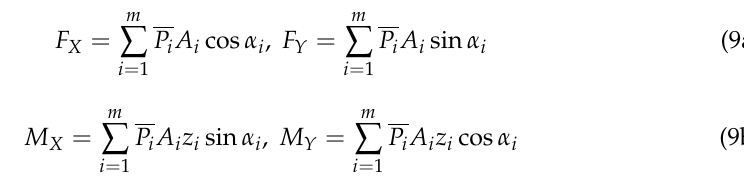
Table 4. Percentage of wind load of the grid structure and core tube in the total wind load. Angle (°)